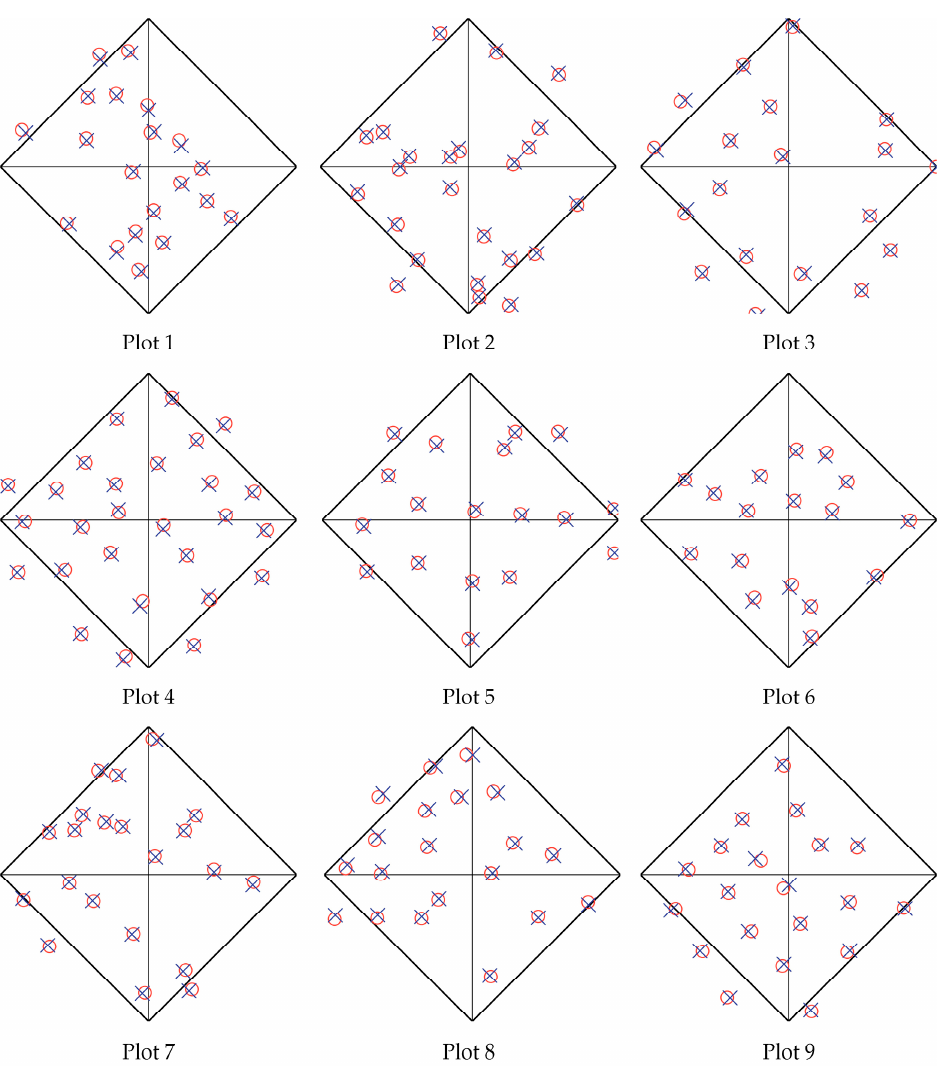
Figure 15. Estimated and reference stem positions: the red circles indicate the stem references; the blue crosses indicate the estimations.